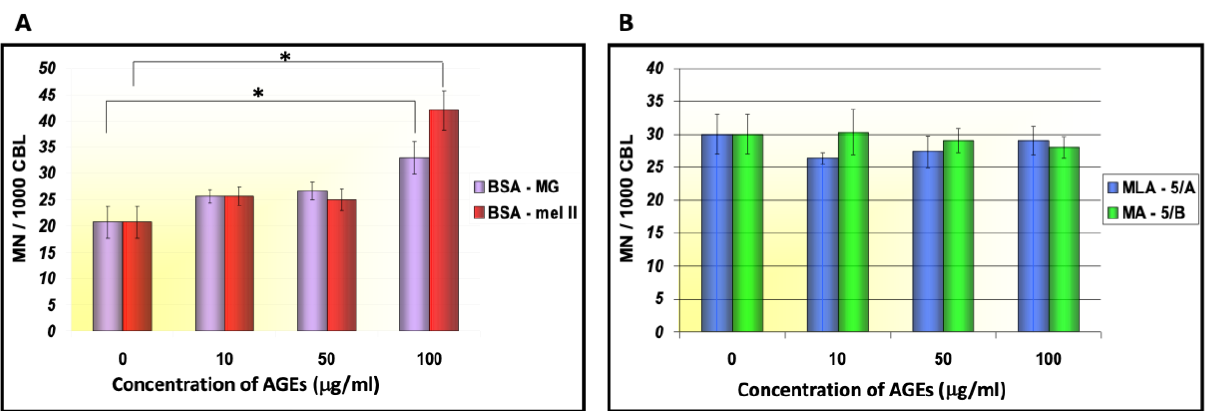
Figure 2. The impact of HMW–MAGE derived from BSA and D-melibiose or methylglyoxal on DNA damage in human PBL ( A ) and genotoxic activity of LMW–MAGE synthesized in reaction of D-melibiose, N -α-acetyl-L-lysine and N -α-acetyl-L-arginine (LMA) or from a mixture of D-melibiose and N -α-acetyl-L-lysine (LM) ( B ); * indicates p < 0.05.